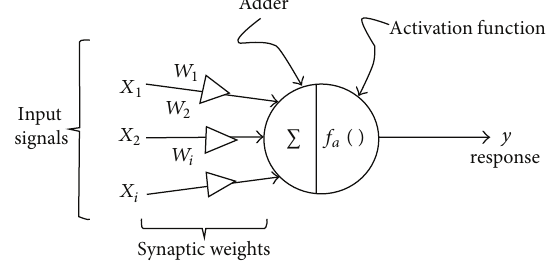
Figure 1: Classical model of a neuron.